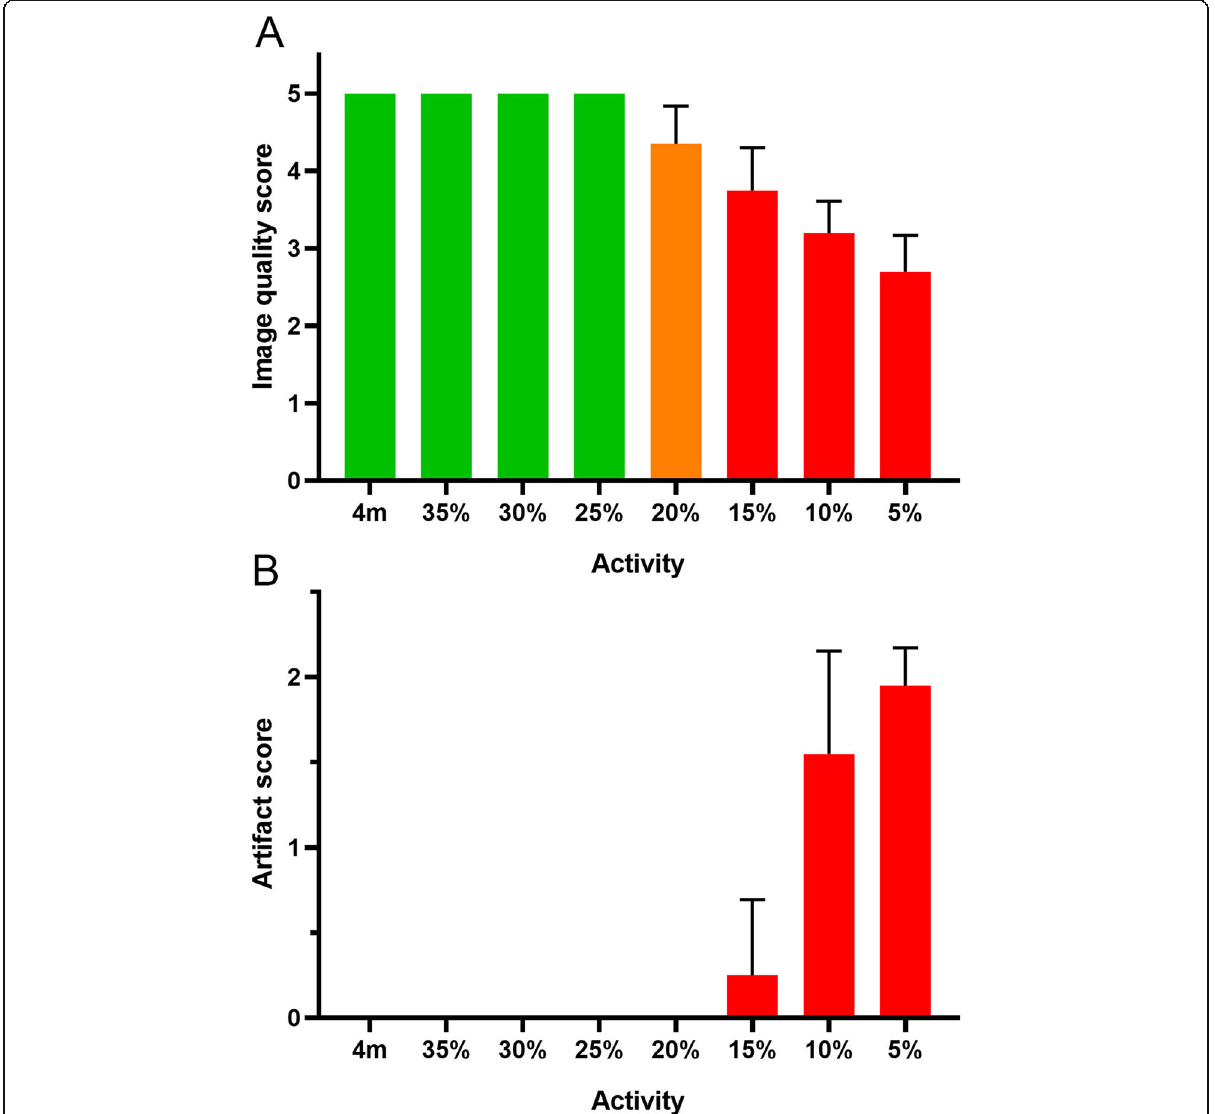
Fig. 2 The image quality and artifact score for the reference and multiple simulated activities. The image quality score ( a ) shows that the 4-min reference reconstruction (4 m) and the reconstructions with 35%, 30%, and 25% of the original activity have a good image quality (green). The 20% reconstructions have a somewhat lower quality (orange). The artifact score ( b ) shows that reconstructions with 15%, 10%, and 5% activity have increasing artifacts (red). Results are reported as mean ±